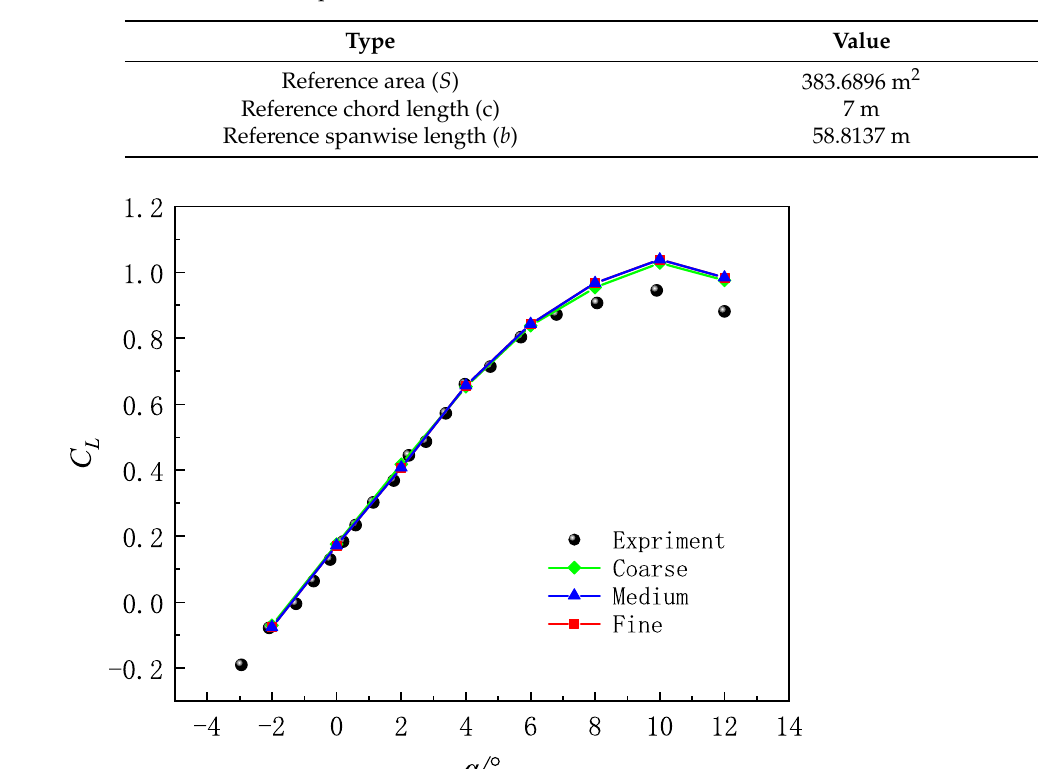
Table 1. Geometric parameters of the CRM.